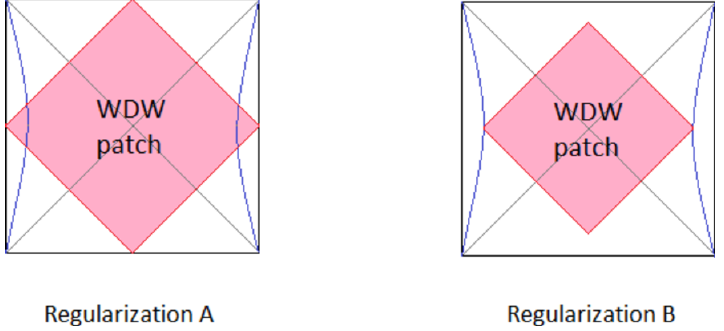
Figure 3 . Two di(cid:11)erent regularizations can be chosen for the action of the WDW patch for black holes in AdS (here for illustrative purpose we show the case of non-rotating black hole in asymptotically AdS